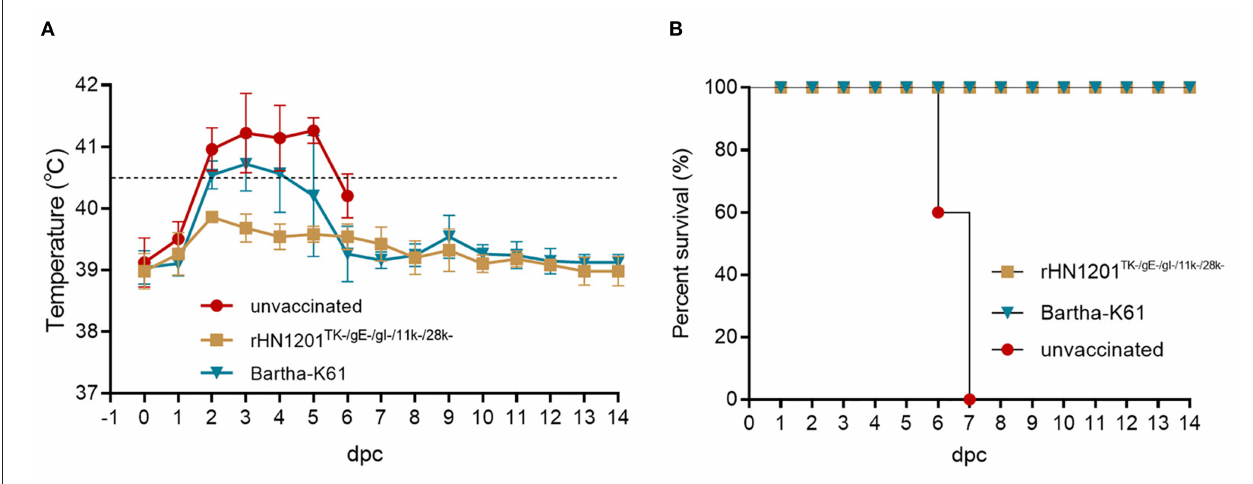
FIGURE 3 | Body temperature and survival rate of pigs after challenge. (A) Body temperature of pigs challenged with HN1201. (B) Survival rate of pigs challenged with HN1201. The survival rates were analyzed by the Kaplan Meier